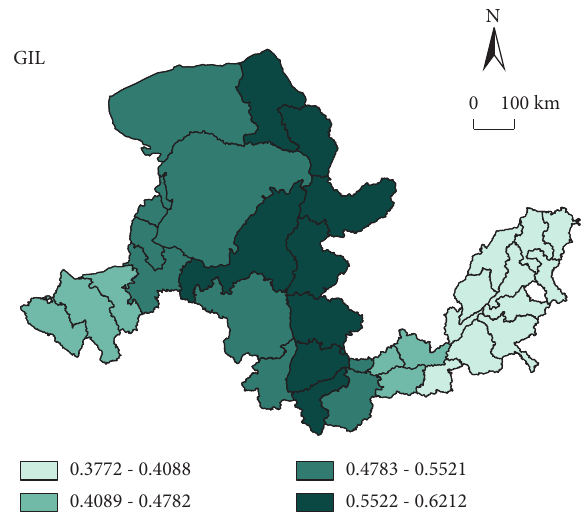
Figure 12: Spatial distribution of regression coefficient of the GIL on